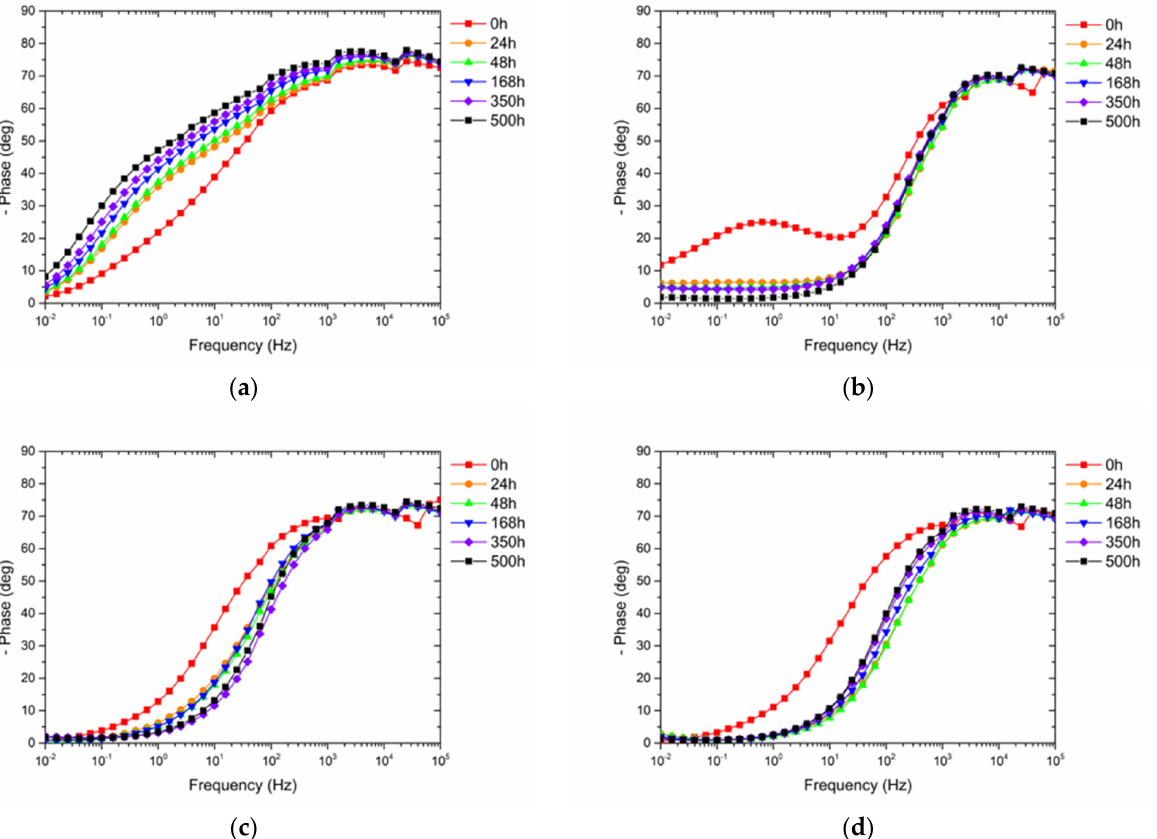
Figure 15. Bode phase spectra evolution with time of ( a ) sample T, ( b ) sample O, ( c ) sample S, and ( d ) sample W.